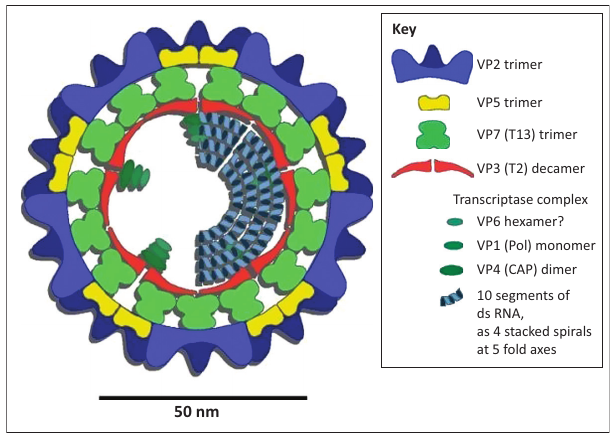
FIGURE 1: Schematic representation of bluetongue virus illustrating the interactions of the different proteins. VP, viral proteins; RNA, ribonucleic acid; CAP, capping enzyme; Pol,